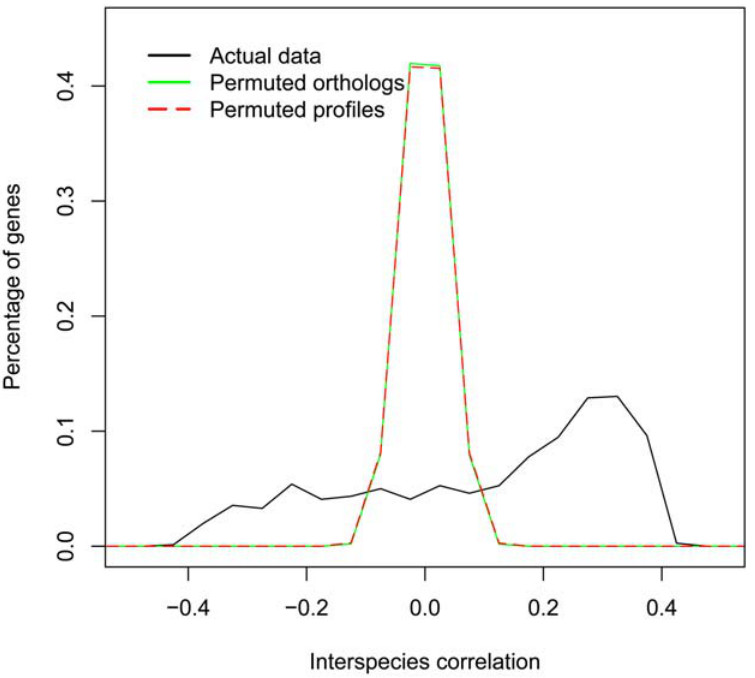
Figure 5. Interspecies correlations are non-random. A comparison of the actual distribution of interspecies correlations and 2 randomized distributions constructed from interspecies correlations computed from a 1000 permutations of the orthologous relationships and a 1000 permutations of expression profiles reveals that the interspecies correlations are non-random.